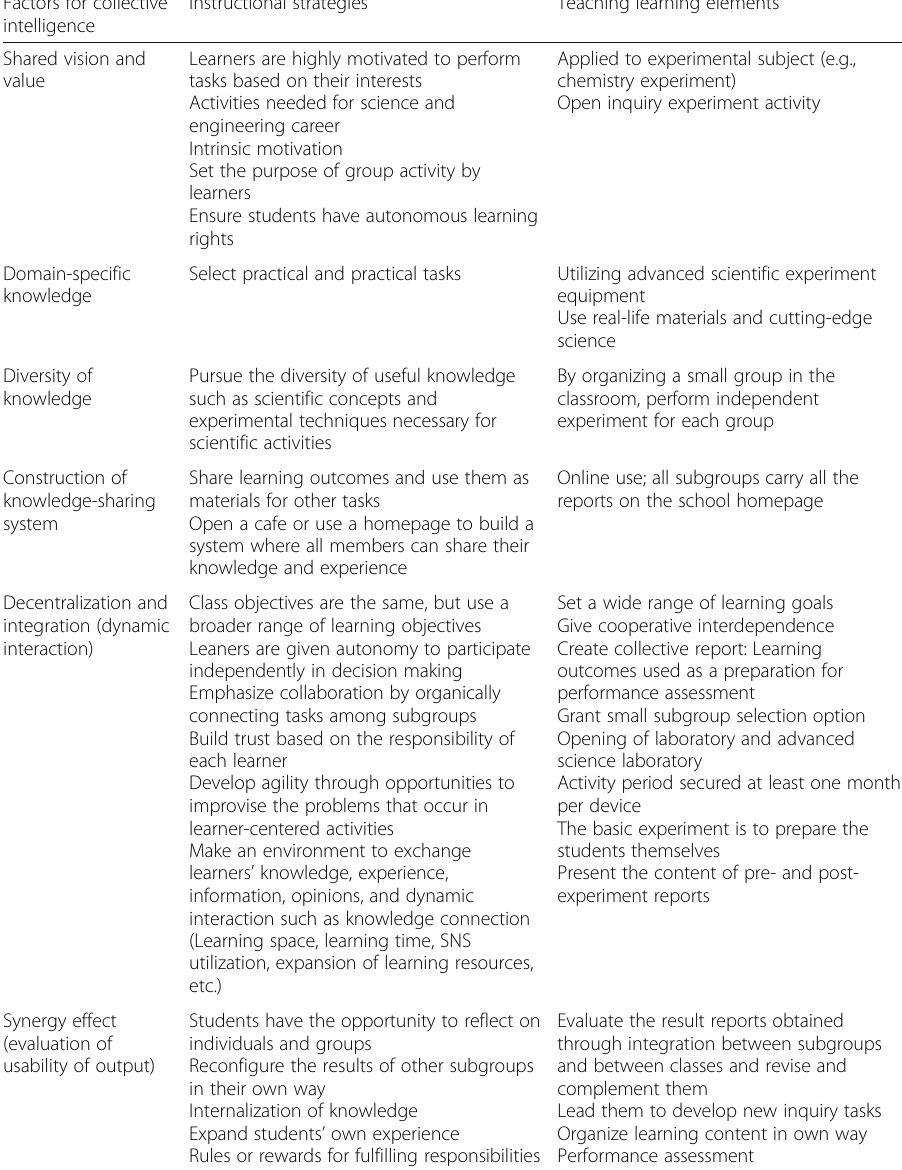
Table 5 Extraction of teaching learning elements from instructional strategies based on collective